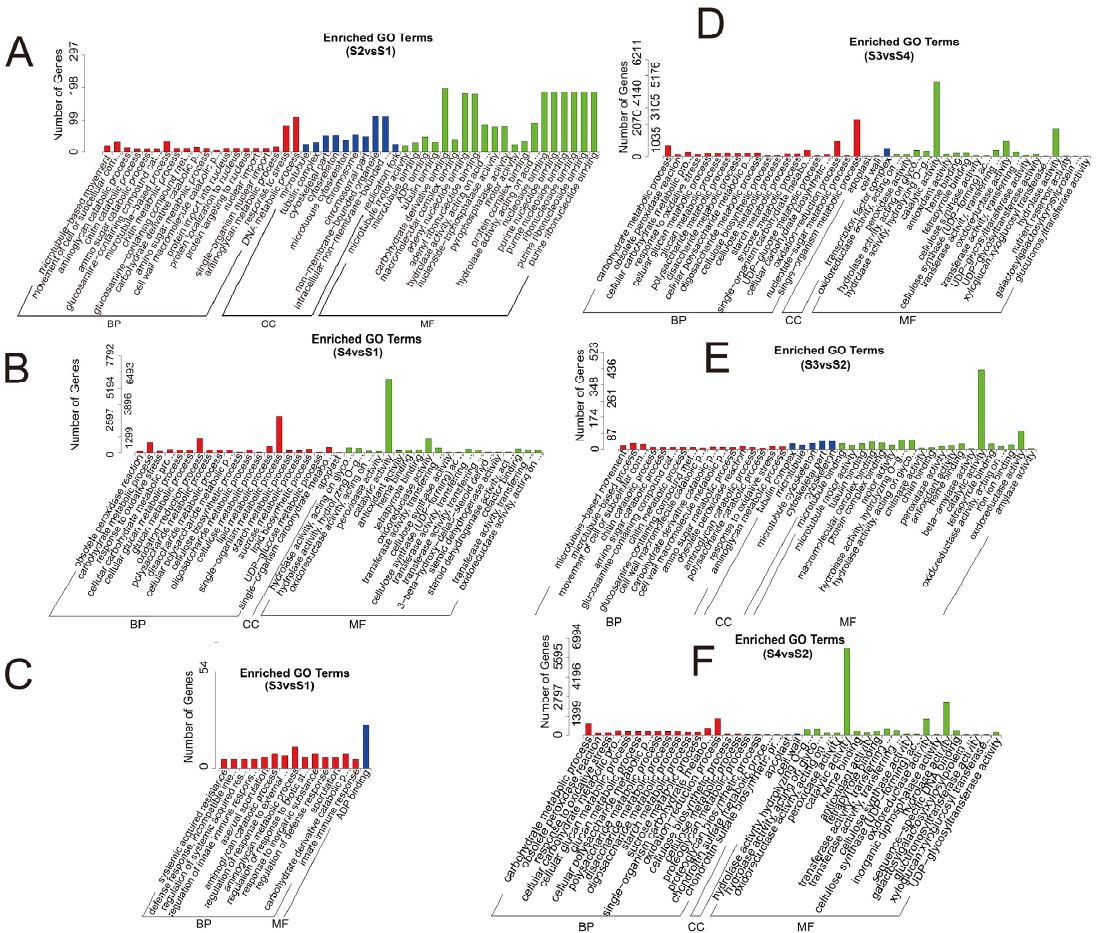
Figure 5. Go enrichment analysis of differentially expressed genes in B. pervariabilis × D. grandis in four periods S1–S4. Note: ( A ): S2 vs. S1; ( B ): S4 vs. S1; ( C ): S3 vs. S1; ( D ): S3 vs. S4; ( E ): S3 vs. S2; ( F ): S4 vs. S2. The red histogram represents biological processes; the blue histogram represents cellular components; the green histogram represents molecular functions.